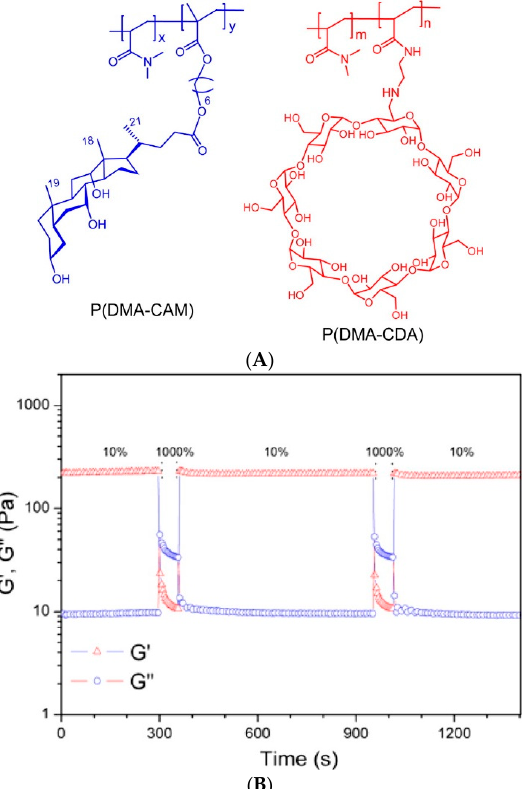
Figure 5. ( A ) Structures of cholic acid- ( left ) and β -CD-bearing ( right ) poly( N , N -dimethylacrylamides), P(DMA-CAM) and P(DMA-CDA), respectively; ( B ) G ′ (squares) and G ″ (circles) values of the P(DMA-CAM-2%)/P(DMA-CDA) hydrogel (8.3 wt%) in continuous step strain measurements (25 °C). Large strain (1000%) inverted the values G ′ and G ″ to give the sol state. G ′ was recovered under a small strain (10%) within 30 s. Reprinted with permission from [63]. Copyright 2016 American Chemical Society.